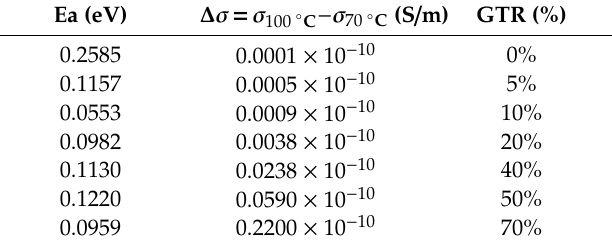
Table 2. Activation energy and conductivity rise in the range of temperatures from 70 to 100 ◦